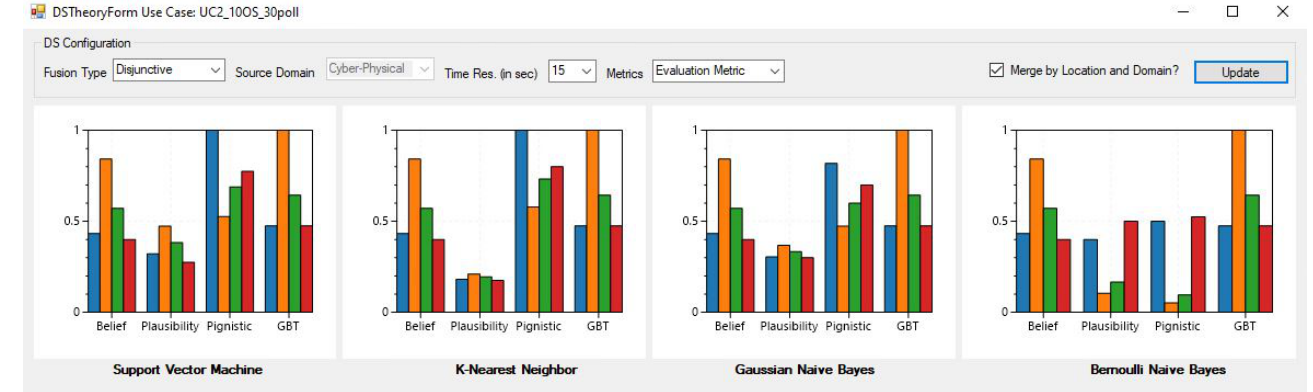
Figure 10. IDEA-I application for evaluating DSTE components for different scenarios, classifiers, and fusion